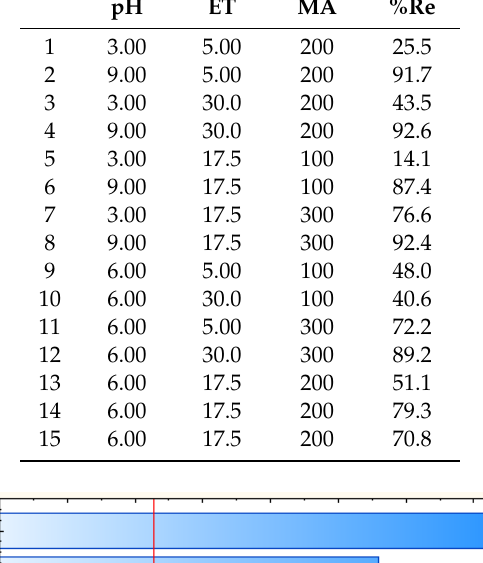
Table 3. Box–Behnken design matrix and analytical response.